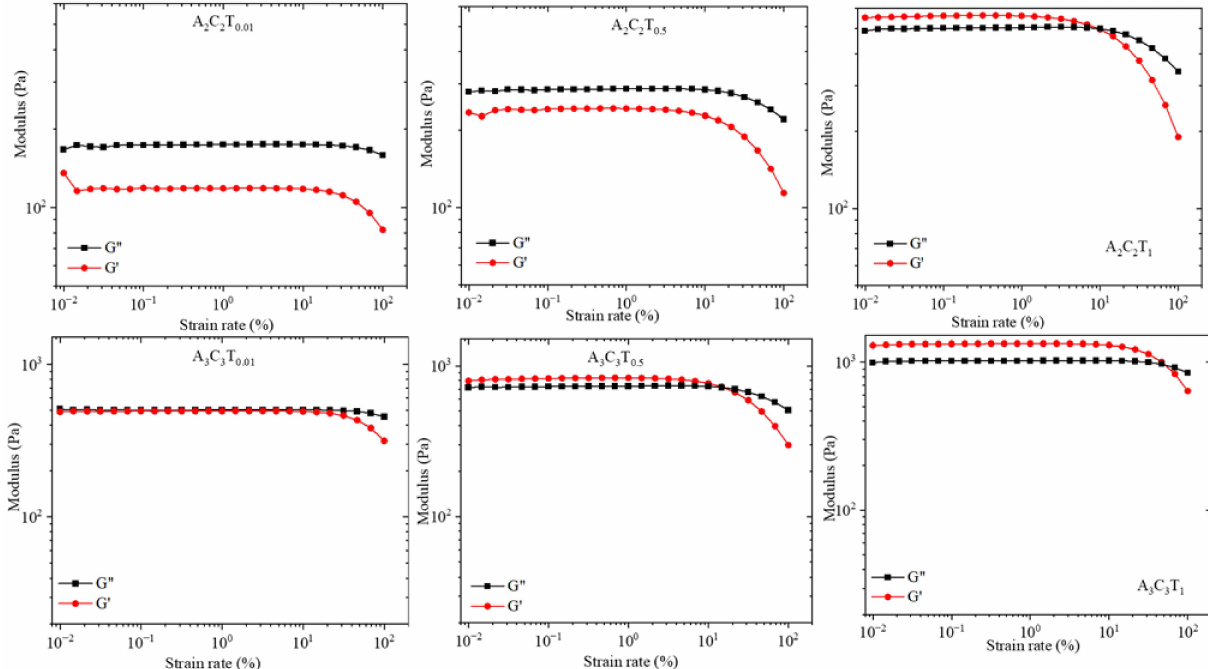
Figure 9. Loss modulus (G (cid:48)(cid:48) ) and storage modulus (G (cid:48) ) of A 2 C 2 T 0.01 , A 2 C 2 T 0.5 , A 2 C 2 T 1 , A 3 C 3 T 0.01 , A 3 C 3 T 0.5 , and A 3 C 3 T 1 resulting from amplitude sweep test. Any composition shows G (cid:48)(cid:48) > G (cid:48) (such as A 2 C 2 T 0.01 , A 2 C 2 T 0.5 , and A 3 C 3 T 0.01 ) represents liquid-like character where G (cid:48) > G (cid:48)(cid:48) (such as A 2 C 2 T 1 , A 3 C 3 T 0.5 , and A 3 C 3 T 1 ) indicates solid-like